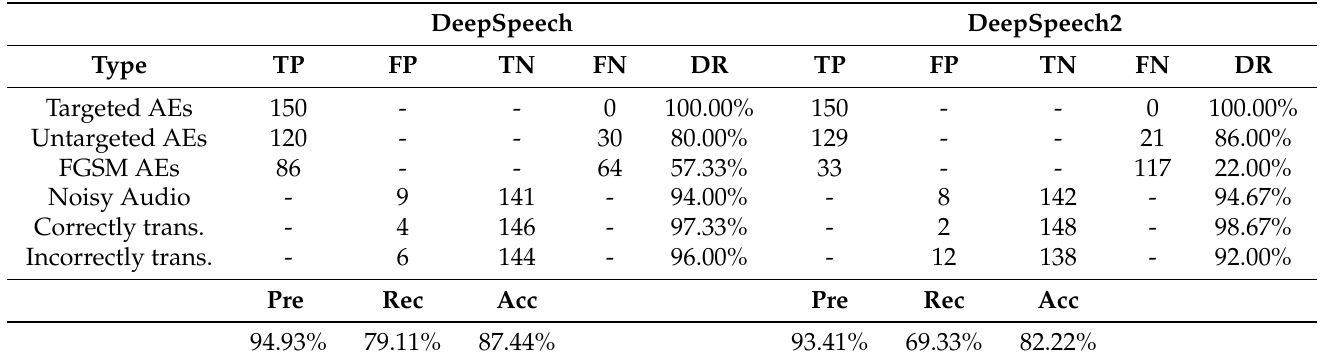
Table 4. Anomaly detection results of previously unknown audio